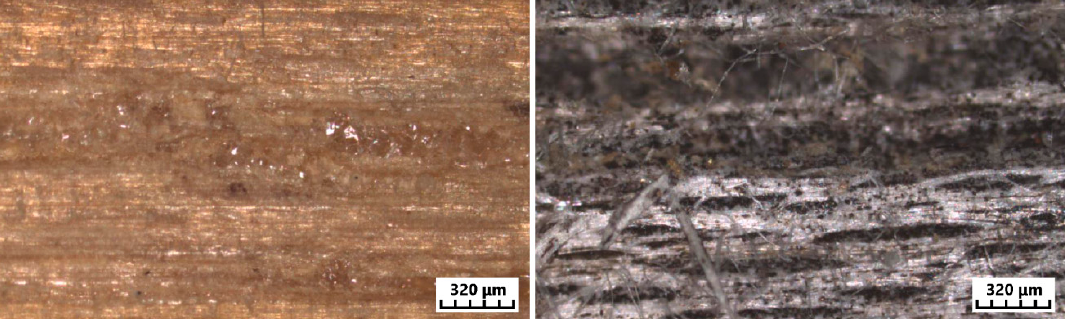
Figure 8. Confocal laser scanning microscopy of oak wood before and after 2 years of weathering (detail). Forests 2018 , 9 , x FOR PEER REVIEW